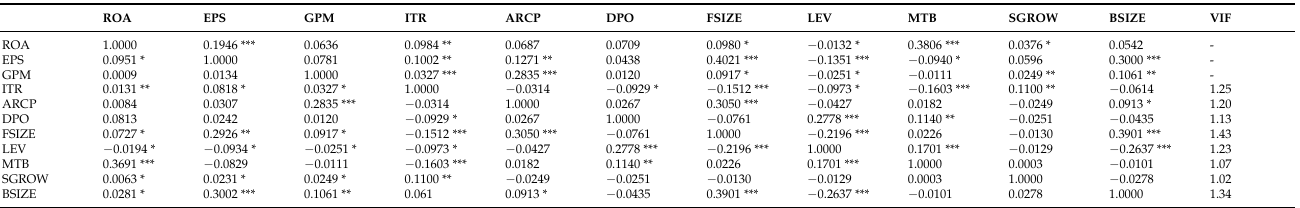
Table 3. Pearson and Spearman correlations matrices and variance inflation factors (VIFs)